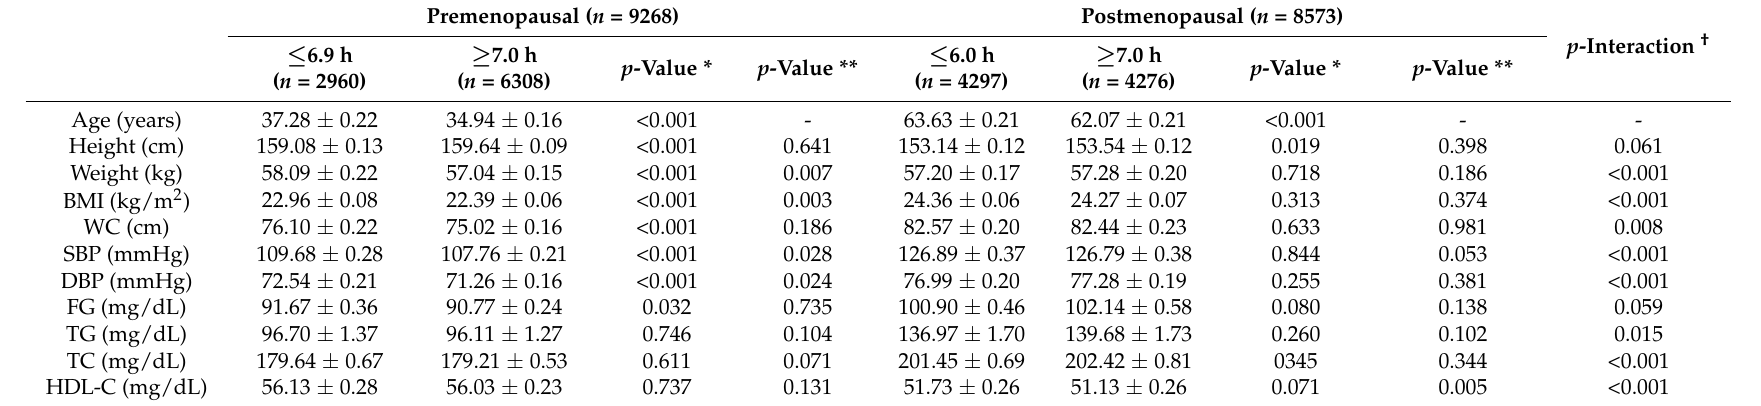
Table 3. Anthropometric and biochemical variables for different sleep duration in participating Korean